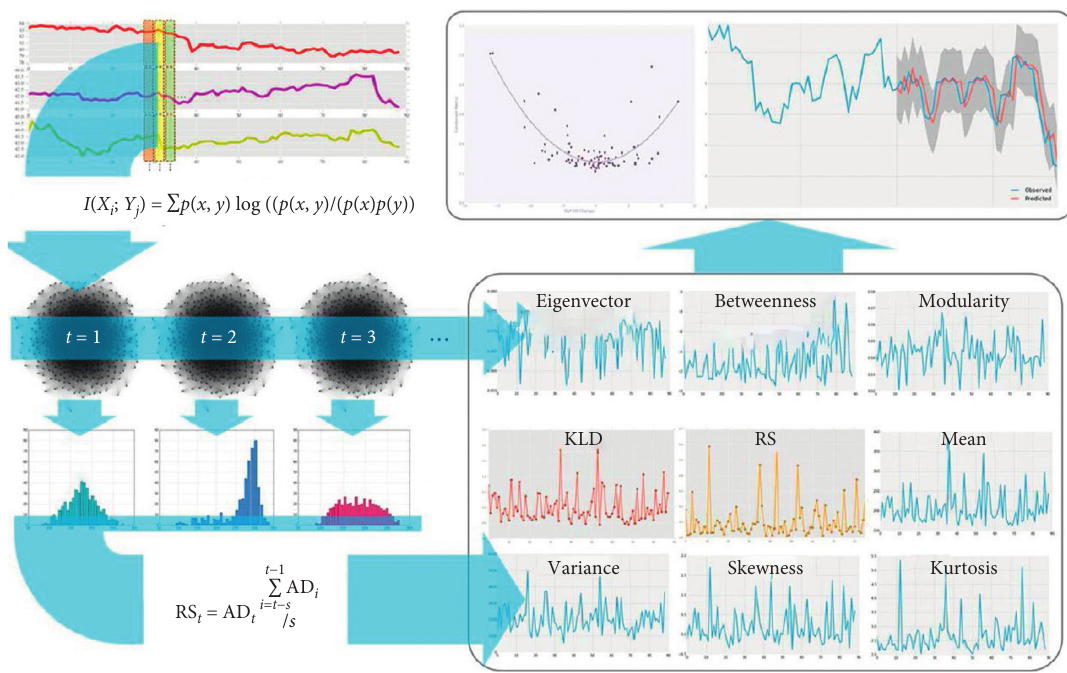
Figure 2: Complex network minority game model financial market modeling process.